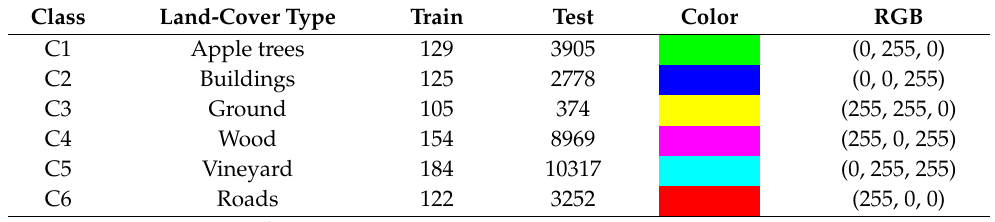
Table 2. Trento data: numbers of training and testing sample, color and RGB value in each class.